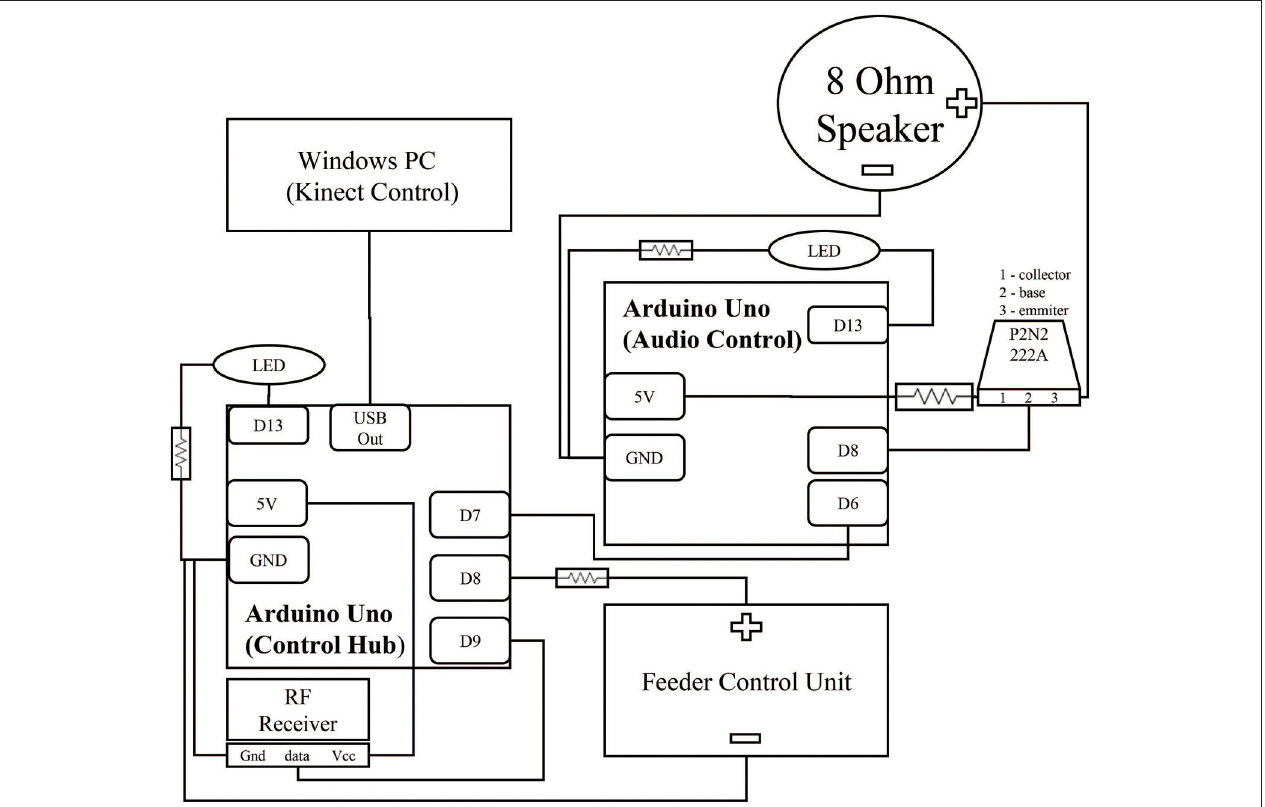
FIGURE 2 | Circuit for control hub and surrounding components. Two Arduinos control the acquisition of the reward event and the subsequent audio feedback signal. Brown lines represent wiring between components. The black squares within the Arduinos represent individual connections to ports. Digital output ports (Dn) were selected for physical convenience and could be interchanged depending on experiment needs. Both Arduinos contain an LED link to extend the embedded Arduino LED feedback system from PIN 13 to increase visibility from further away. This LED was hidden from the monkey’s view during experimentation. All hardware was packaged in a simple cardboard